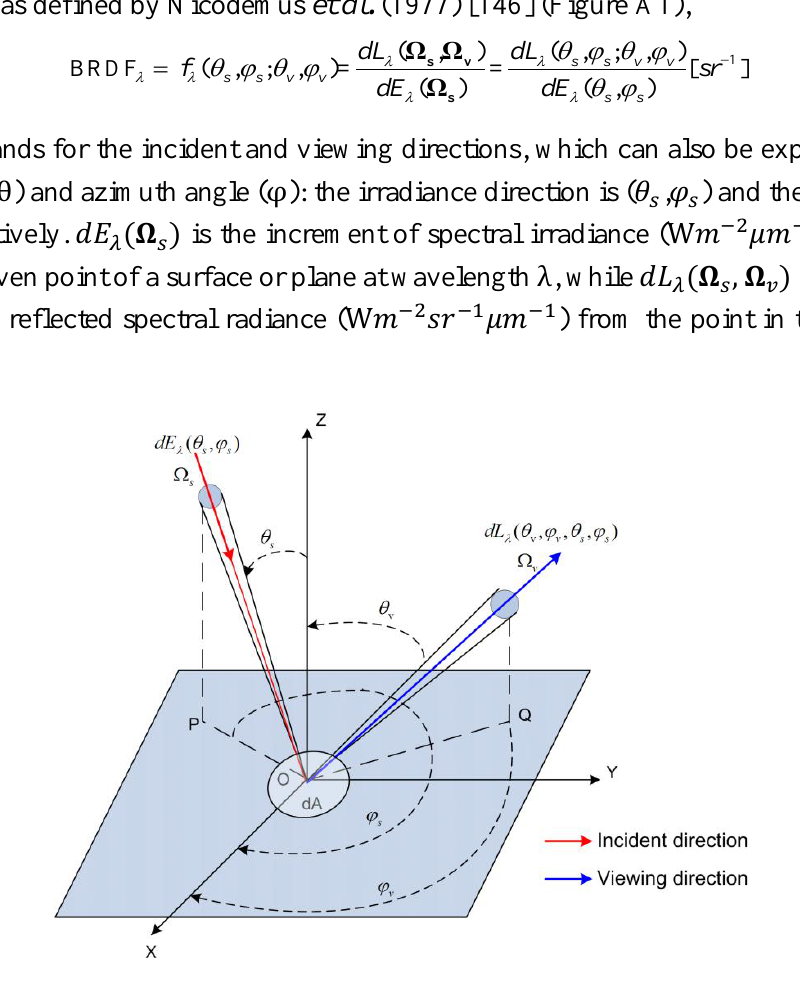
Figure A1. Incident and viewing geometries for definition of